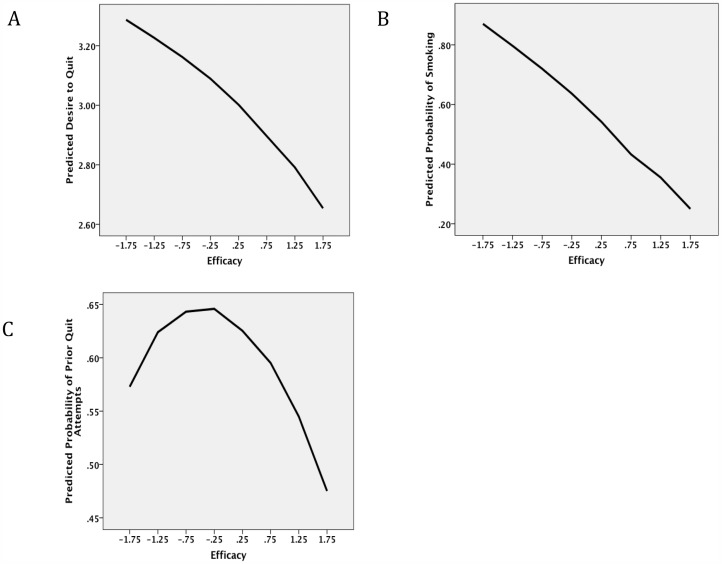
Predicted relations between three measures and efficacy to quit based on regression models in Tables 2 and 3: (A) desire to quit; (B) probability of smoking frequency; and (C) probability of trying to quit in past 12 months.